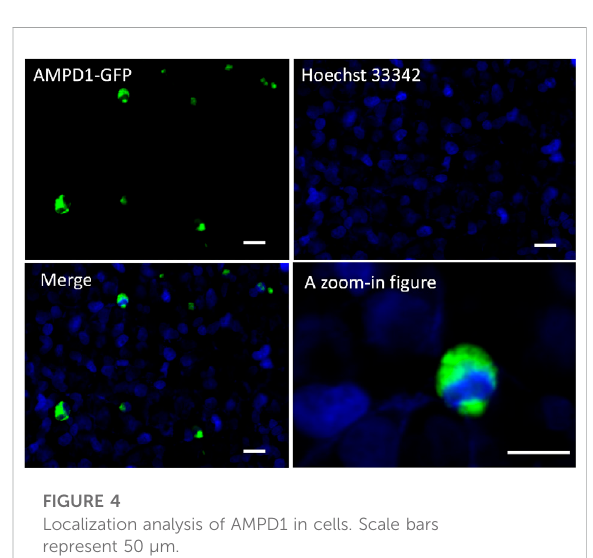
FIGURE 4 Localization analysis of AMPD1 in cells. Scale bars represent 50